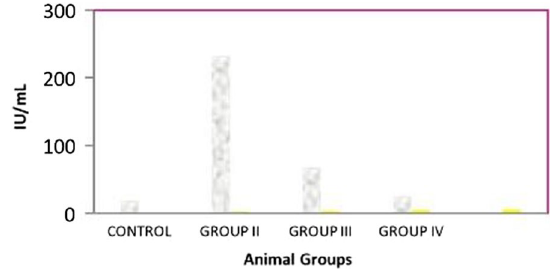
Fig. 12 Effect of Trichoderma viride extract on CA-125